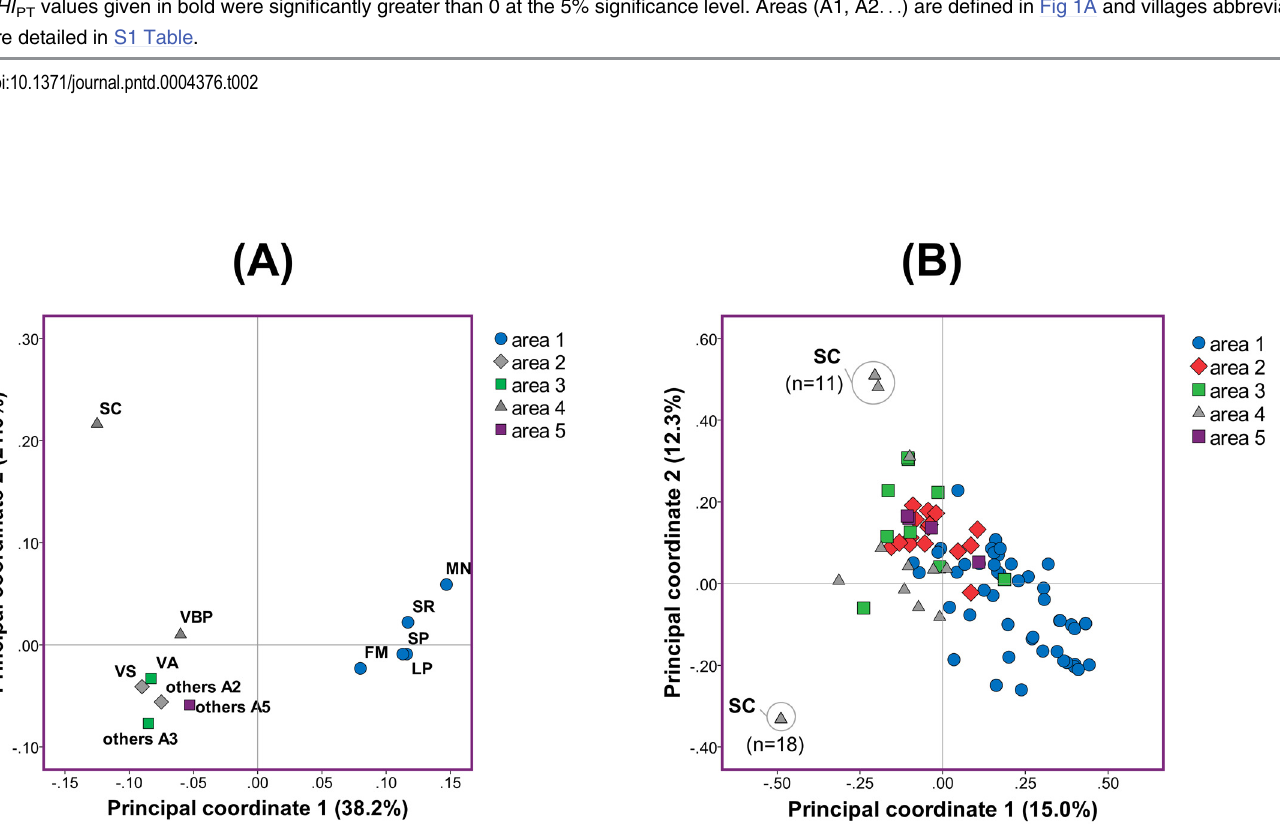
Fig 3. PCoA of the parasite population at village and individual haplotype level. (A) Principal coordinate analysis of the study areas resulted from intercomparison of individual villages. Percentages in the parenthesis indicate the proportion of total variation explained by each principal coordinate. The term “ others ... ” was used to group villages within specific areas that had less than 2 isolates with known haplotype. (B) PCoA among the individual haplotypes within the areas. Areas are defined in Fig 1A and village abbreviations are detailed in S1